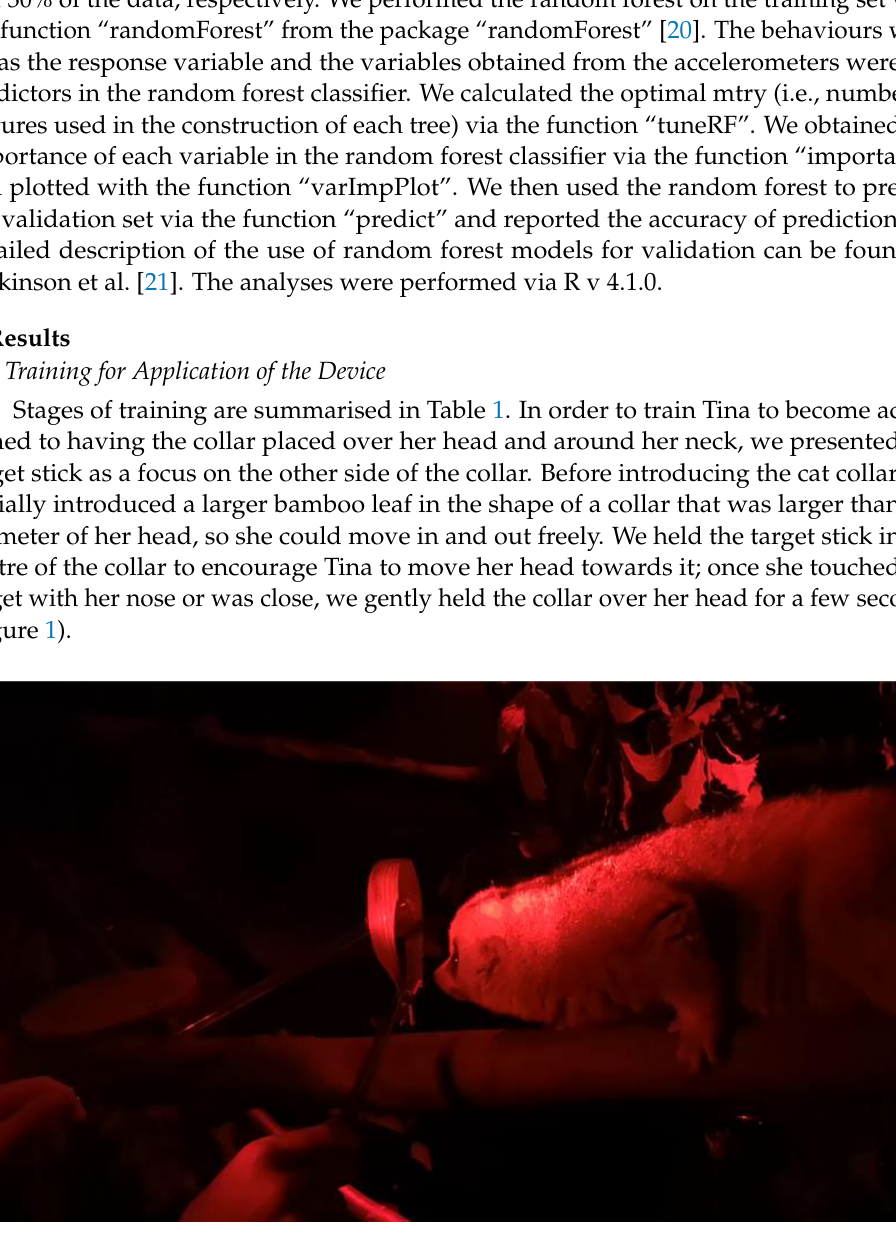
Figure 1. Tina the Bengal slow loris being presented with the bamboo leaf collar with tongs during the initial stage of the training. the initial stage of the